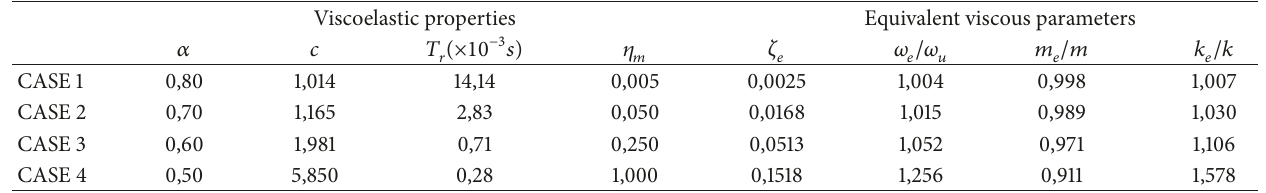
Table 1: Example 1: single-degree-of-freedom system. Parameters of the proposed equivalent viscously damped system. Mass and stiffness of the SDOF model: 𝑚 = 1 kg and 𝑘 = 5